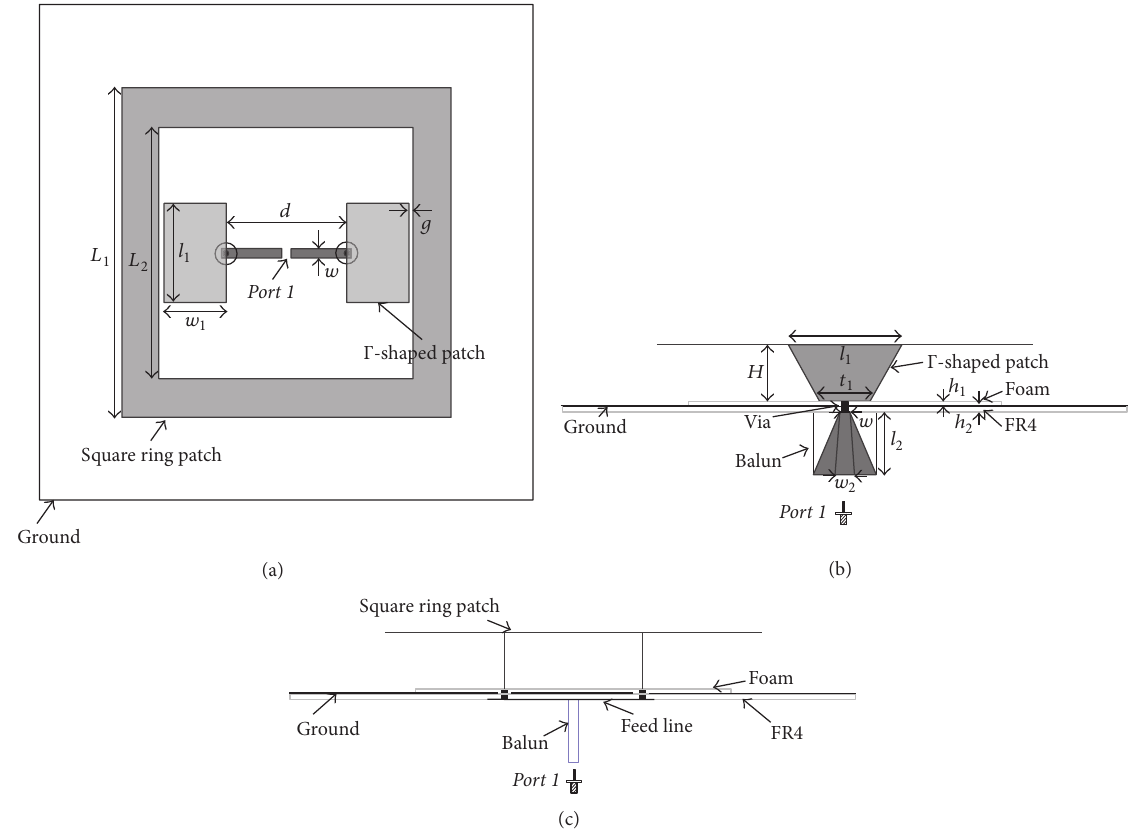
Figure 1: Geometry of the proposed single-polarized UWB patch antenna: (a) top view, (b) side view, and (c) front view. 𝐿 1 = 65 mm, 𝐿 2 = 45 mm, 𝑙 1 = 18mm, 𝑤 1 = 11.3 mm, 𝑡 1 = 14mm, 𝑑 = 22 mm, 𝑔 = 0.1 mm, 𝑤 = 1.5mm, 𝑤 2 = 3.1mm, and 𝑙 2 = 20 mm, 𝐻 = 9 mm, ℎ 1 = 3.2 mm, and ℎ 2 = 0.8